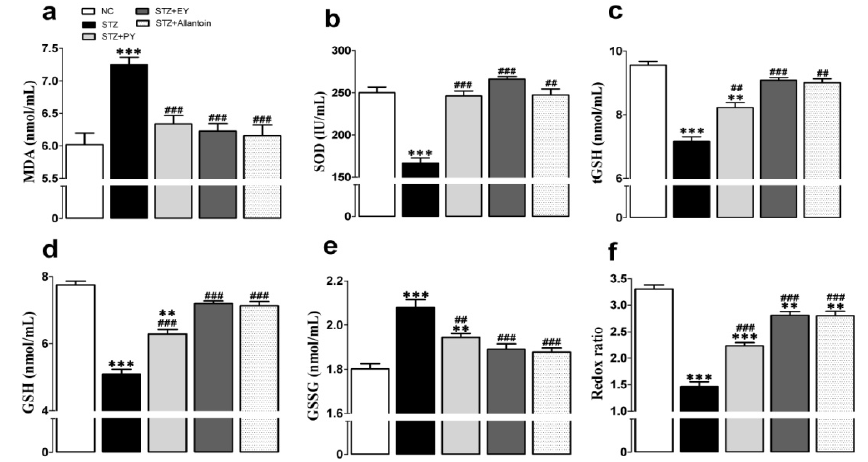
Figure 5. Effects of PY, EY, and allantoin treatments on serum lipid peroxidation and antioxidant activities in STZ ‐ induced diabetic rats. MDA. Malondialdehyde (a); SOD, superoxide dismutase (b); tGSH, total glutathione (c); GSH, reduced glutathione (d); GSSG, oxidized glutathione (e); GSH/GSSG, ratio of GSH to GSSG (redox ratio) (f). Data are reported as means ± SEMs ( n = 10). *: p < 0.05;